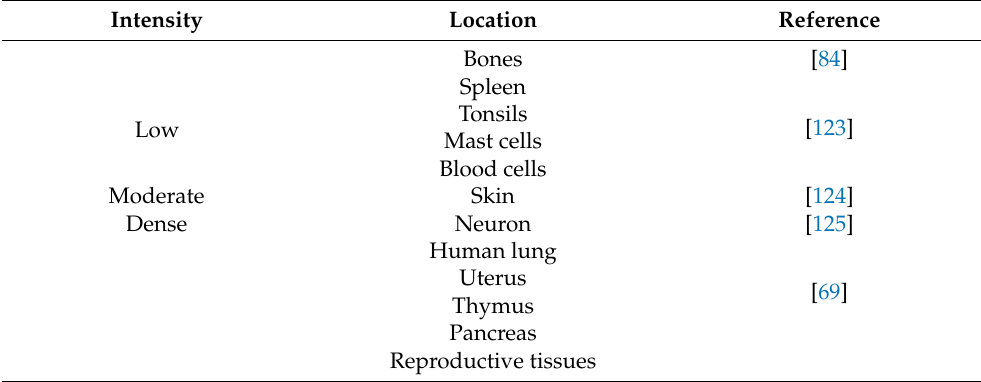
Table 2. The location and intensity of CB2 receptors in the human